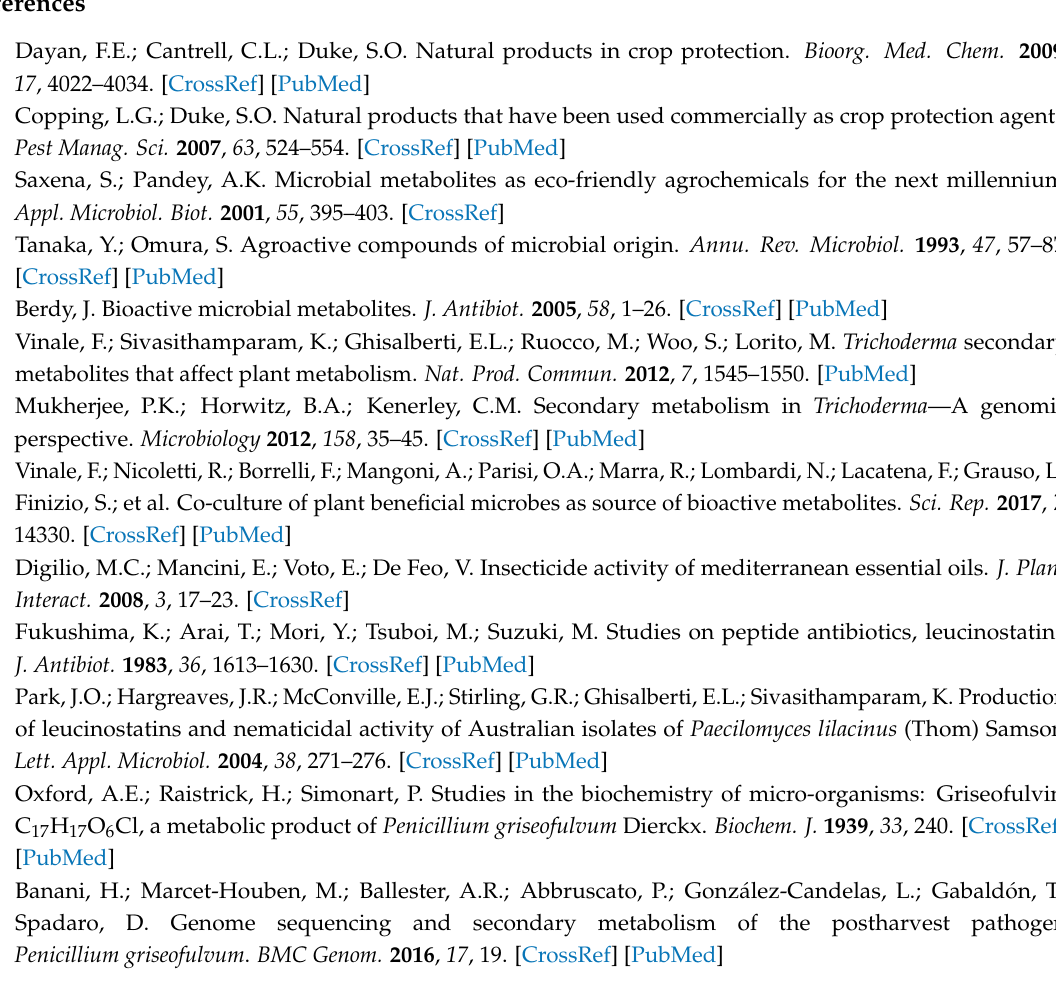
of compounds. Figure S12: Conformational model of the new compound named chlamyphilone. Table S1: Biological activity of the isolated